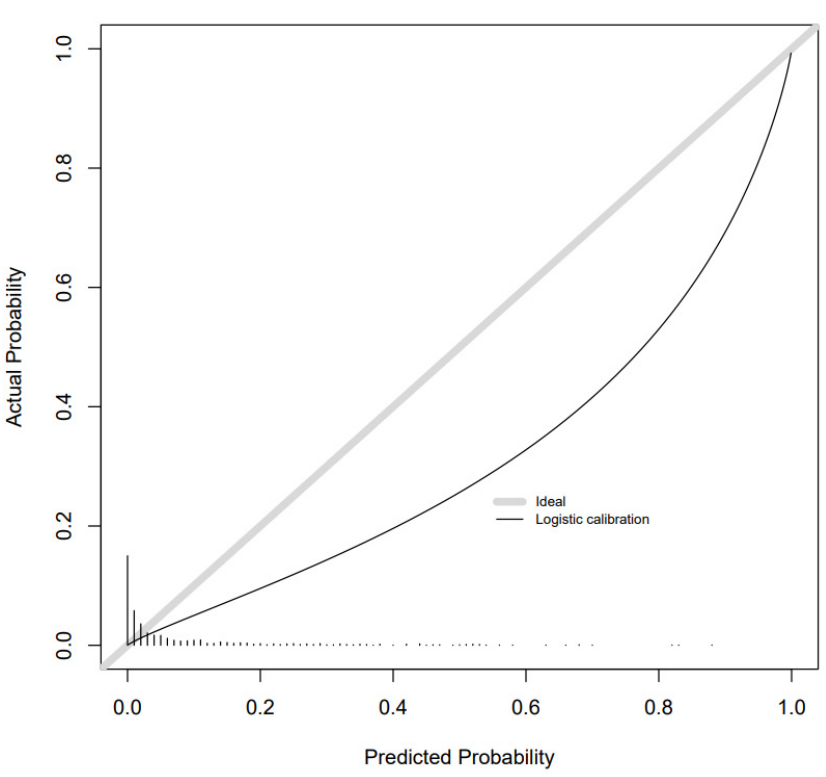
Figure 2. Calibration slope for GDM combined model in BiB 1000 testing sample.